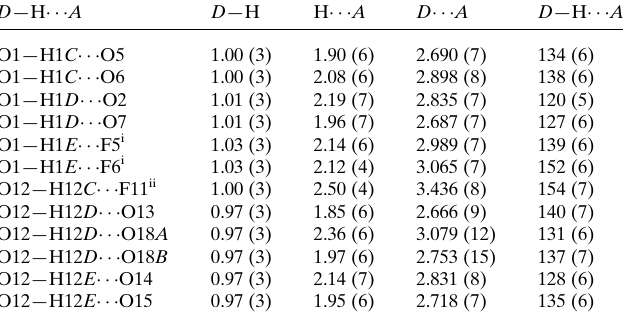
Table 1 Hydrogen-bond geometry (A˚ , (cid:5) ).